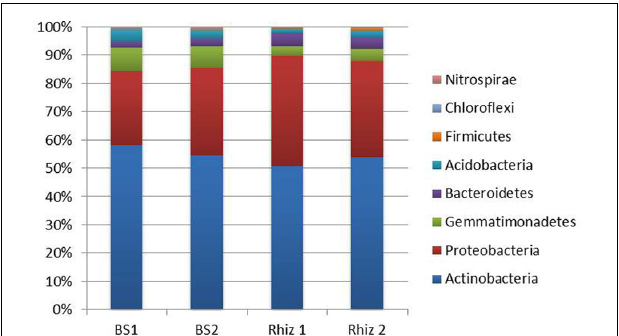
FIGURE 3 | Microbial community composition in the bulk soil and rhizosphere of V. vinifera cv. Pinot Noir at the two sampling times (flowering and early fruiting) at the phylum level (top 8 taxa).